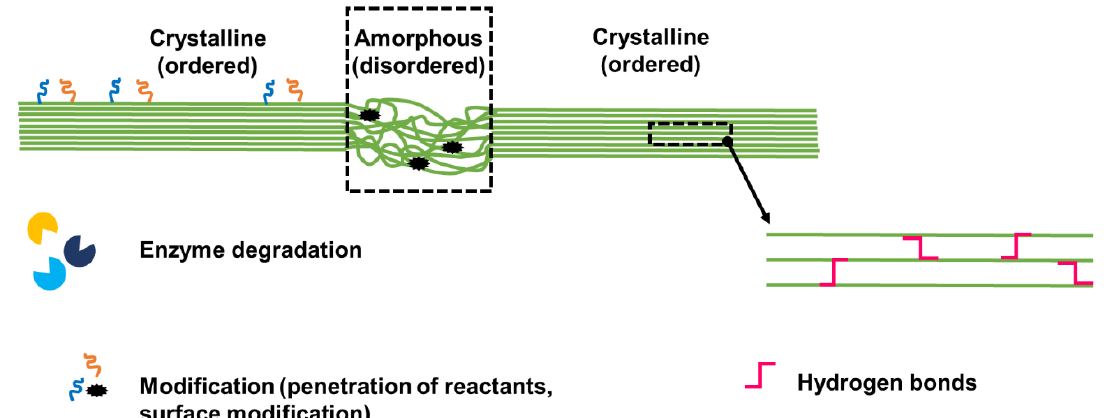
Figure 2. Cartoon showing the crystalline and amorphous regions of cellulose, with schematic details showing that the amorphous region can be attacked by enzymes and is susceptible to modifications (via the easier penetration of reactants). Only the surface of the crystalline region can be modified, as the core is tightly packed and characterized by hydrogen bonds.